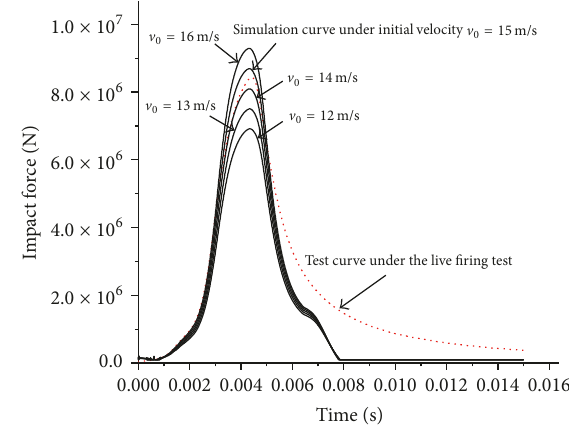
Figure6:Shockforcecurveofthehigh-powerhydraulicshockwave simulator under various initial velocity V 0 .